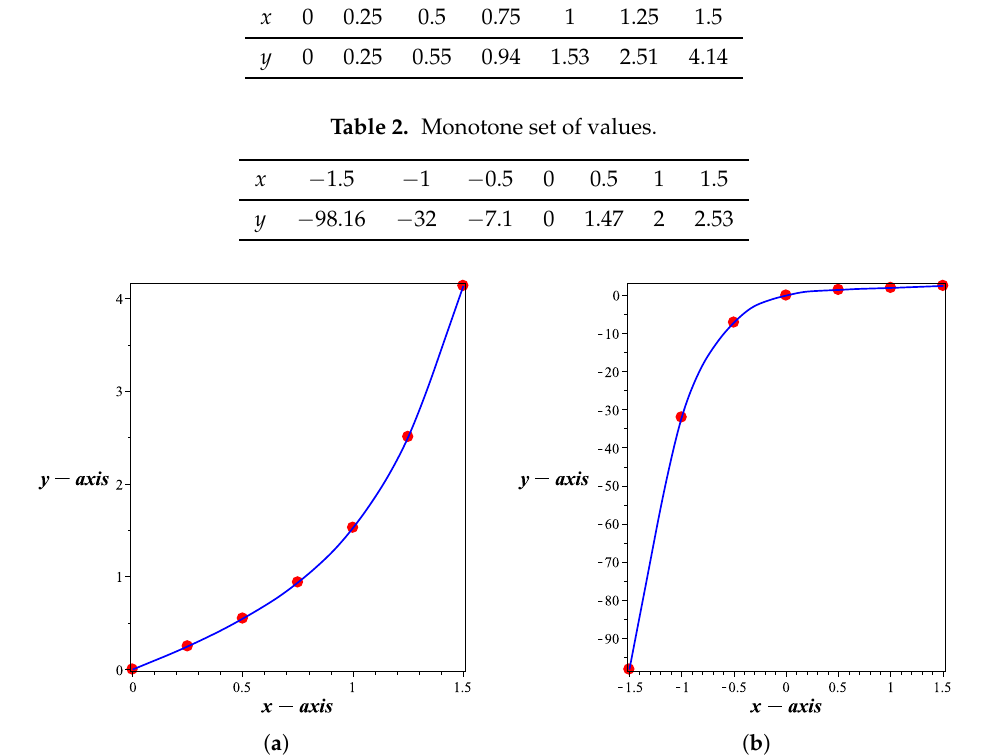
Figure 7. The monotone curves generated by the FPR -scheme (4). ( a ) Monotone curve at u = 0 and ( b ) Monotone curve at u = 0.0076.